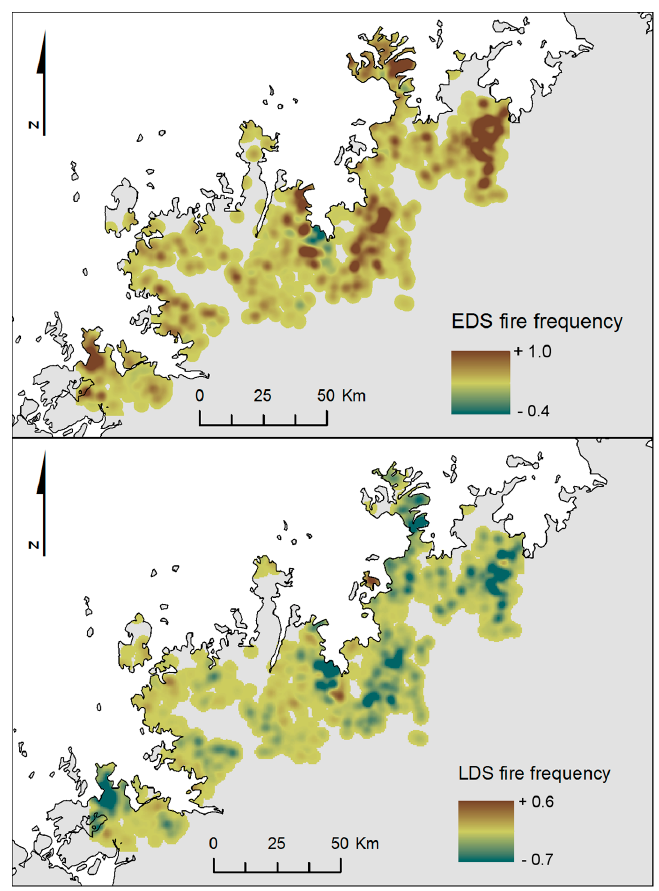
Figure 6. Heat maps displaying variations in the frequency of early dry season (EDS) fires and late dry season (LDS) fires in proximity of rainforests between the baseline years and (2000–2009) and the project years (2012–2015). Note the heat maps reflect change in fire frequency not actual fire frequency as per Figure 5.